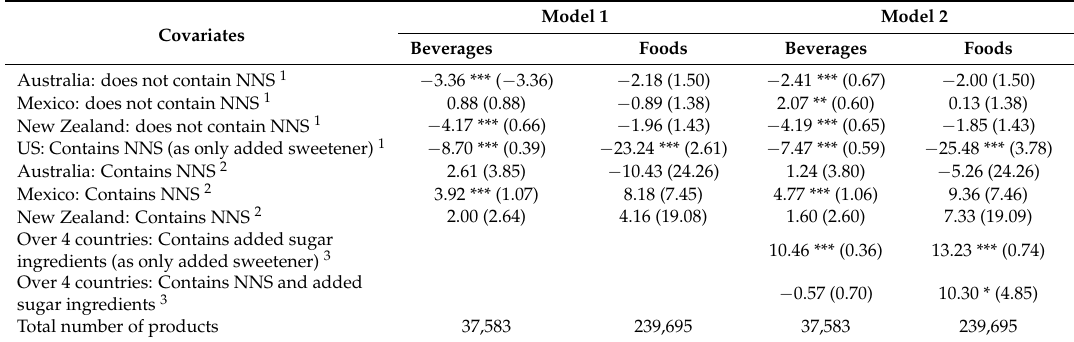
Table 3. Coefficient estimates (SE) of total sugar density in beverages (g/100 mL) and foods (g/100